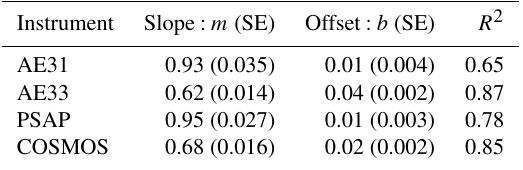
Table 4. Linear regression statistics (correlation coefficients and standard error, SE) and R 2 values for 1h average absorption co- efficient measured with filter-based instruments y = m + bx , where x = MAAP and y = AE31, AE33, PSAP, or COSMOS. All pre- sented correlations are statistically highly significant ( p < 0 . 001) and calculated at λ =